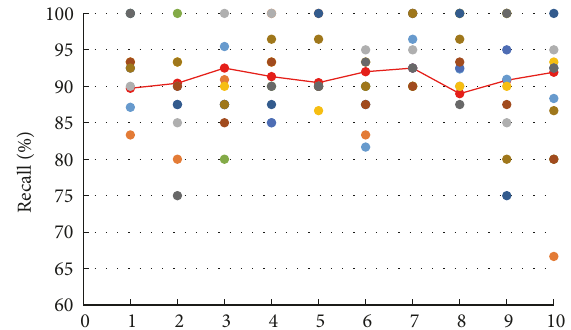
Figure 3: Result of random walk (the ten colors of the points indicated ten 10-fold cross-validation, and the same color of points indicated the validation process. The points connected by a line were the average recall value of ten experiments. The 𝑥 -axis was the 10- step verification of the 10-fold cross-validation process).